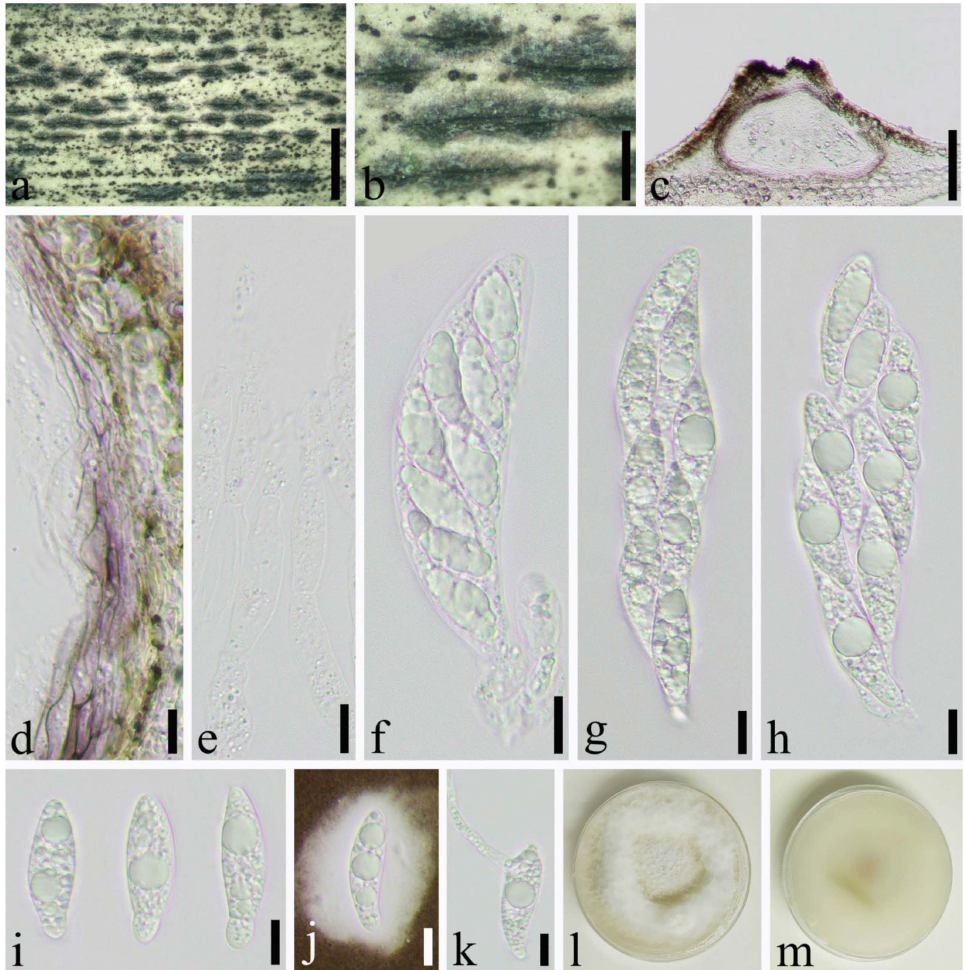
Figure 6. Apiospora jiangxiensis (SICAU 22-0070). ( a , b ) Ascostromata developing on bamboo culm. ( c ) Vertical sections of ascostromata. ( d ) Peridium. ( e ) Paraphyses. ( f – h ) Asci. ( i , j ) Ascospores. ( k ) Germinating ascospore. ( l , m ) Cultures on PDA. Scale bars: ( a ) = 2 mm, ( b ) = 500 µ m, ( c ) = 100 µ m, ( d – k ) = 10 µ